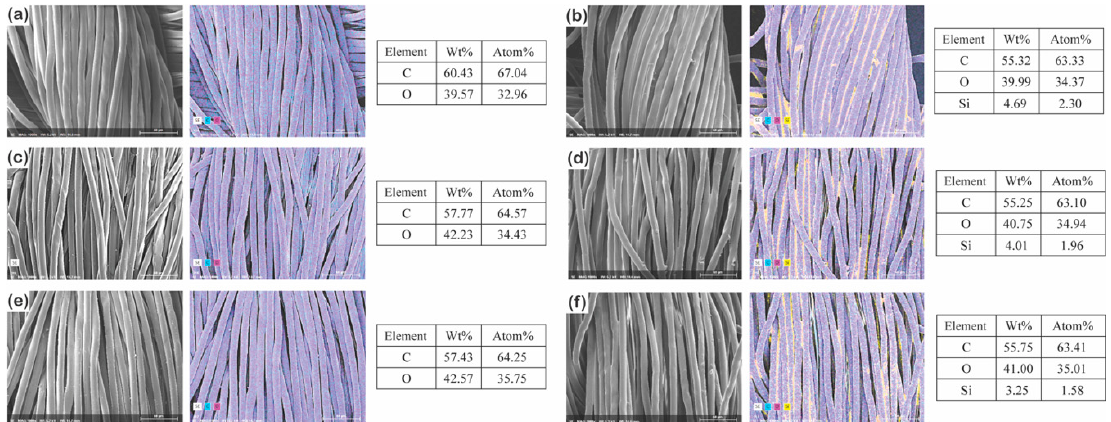
Figure 12. Surface chemical composition of untreated ( a ) and P1T4 PDMS-coated 177D ( b ), untreated ( c ), and P1T4 PDMS- coated 314D ( d ) and untreated ( e ) and P1T4 PDMS-coated 475D ( f ). Different colors indicate different elements such as carbon (C) in light blue; oxygen (O) in magenta; and silicone (Si) in yellow (×1000).